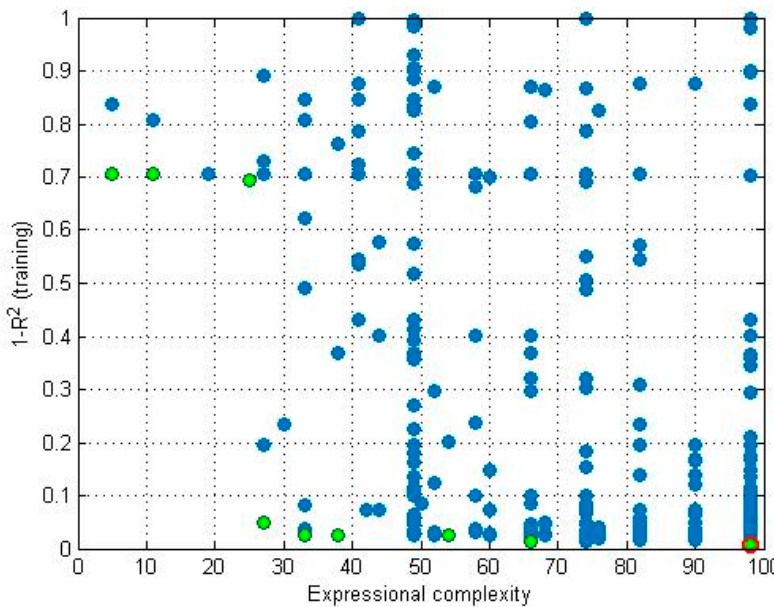
Figure 12. Expressional complexity of the proposed Multi-Gene model.